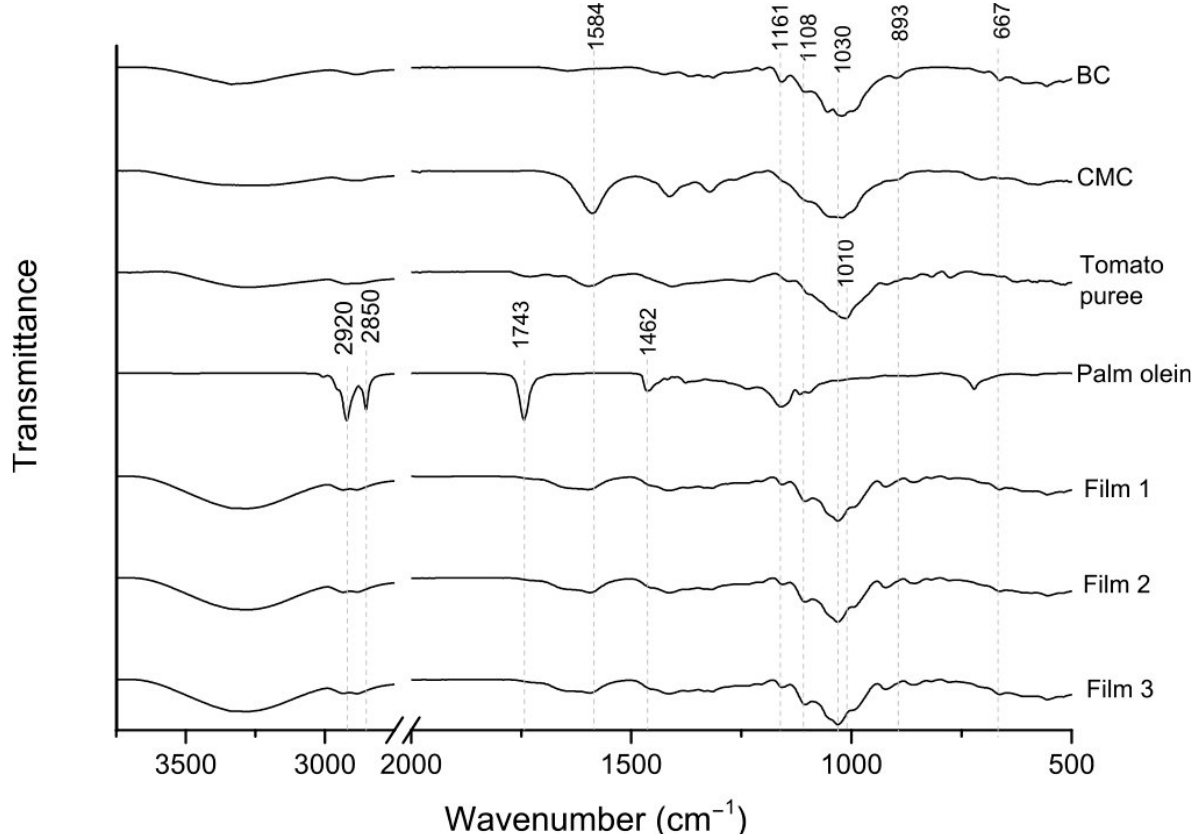
Foods 2022 , 11 , x FOR PEER REVIEW Figure 2. FTIR spectra of film components and films. Figure 2. FTIR spectra of film components and films.